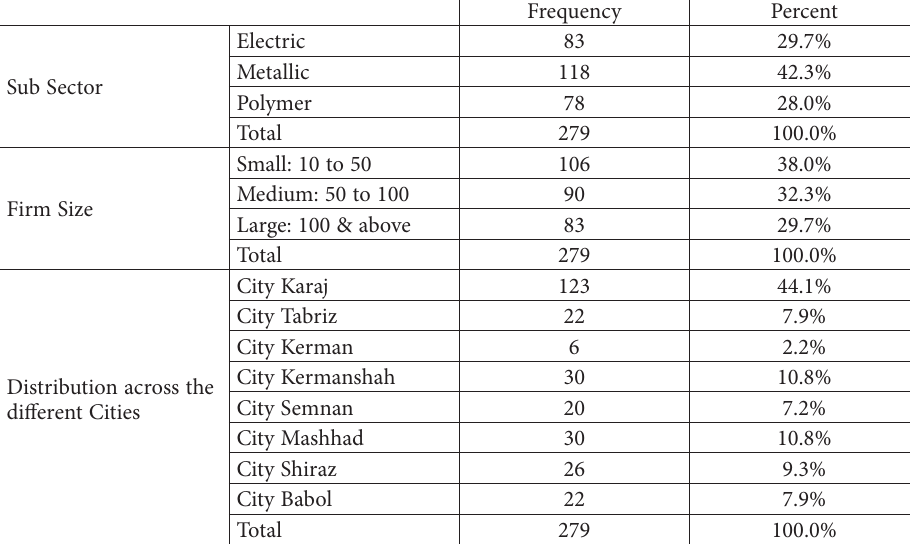
Table 2. Profile of respondents/units of